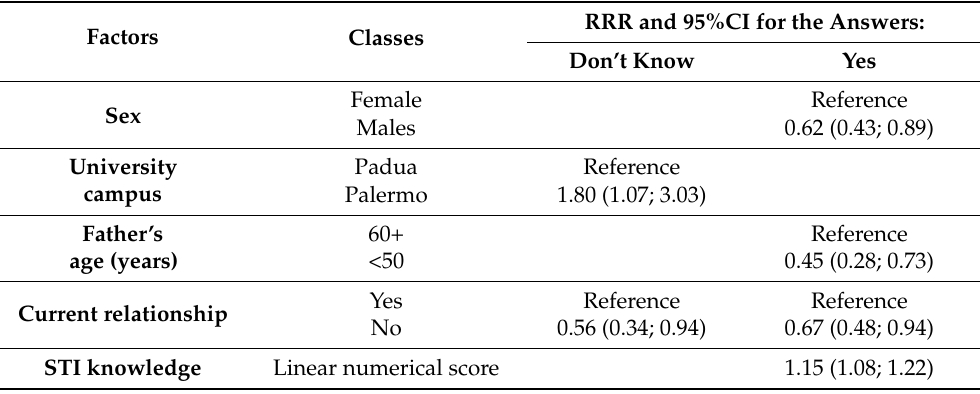
Table 7. Outcome 3 (three answers to the question on whether students had ever contracted a STI). Multivariable analysis of multinomial regression: relative risk ratios (RRR) with 95% confidence interval (95%CI) for answers “Don’t know” and “Yes” compared to the base outcome